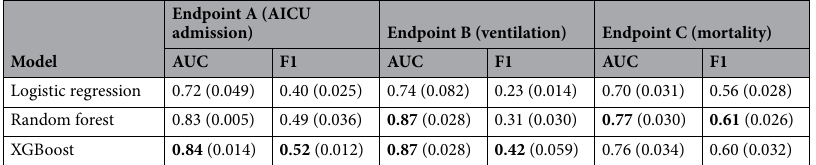
Table 4. Model performance on clinical endpoint prediction (standard deviation shown in brackets). Best model in